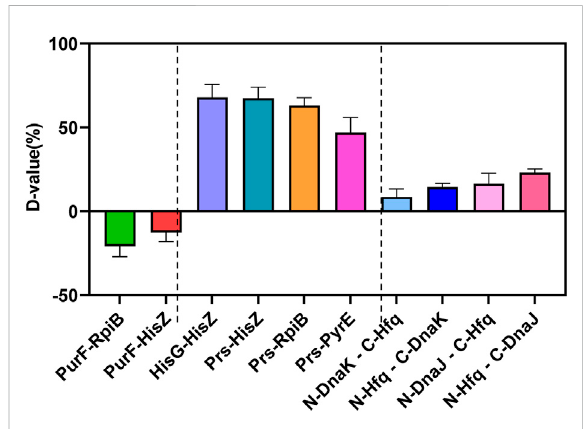
FIGURE 5 Protein-protein interactions of Hfq-DnaK and Hfq-DnaJ detected by the TEV protease mediated Yeast Endoplasmic Reticulum Sequestration Screening system. D-value: the difference of mono fl uorescence signal between experimental samples and control pESE; PurF-RpiB, PurF-HisZ: negative control of protein-protein interaction; HisG-HisZ, Prs- HisZ, Prs-RpiB; Prs-PyrE: positive control of protein-protein